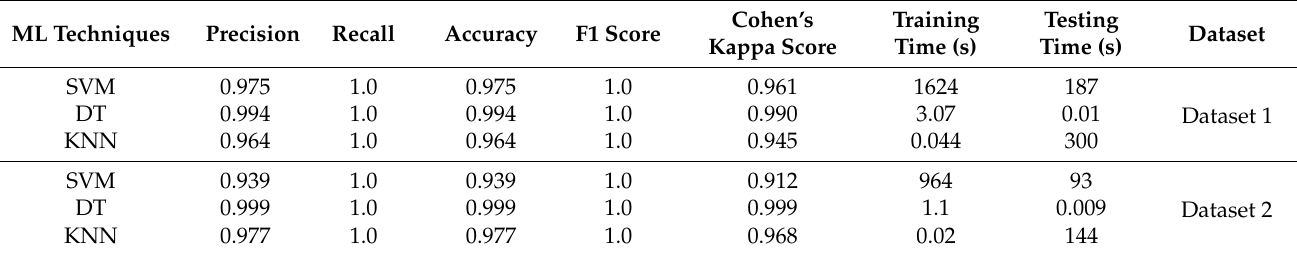
Table 9. A performance comparison of different ML techniques and datasets.